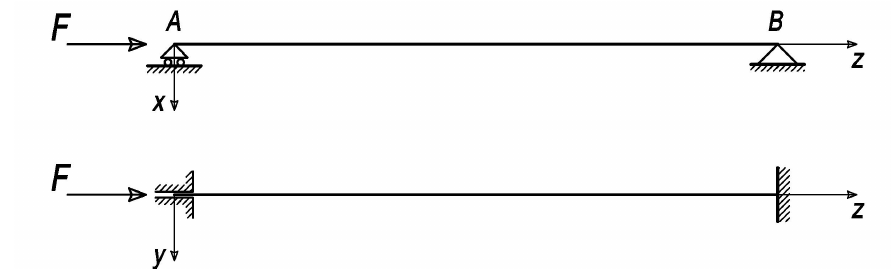
Figure 2. Theoretical model: load arrangement and support conditions (case with cylindrical hinges at both